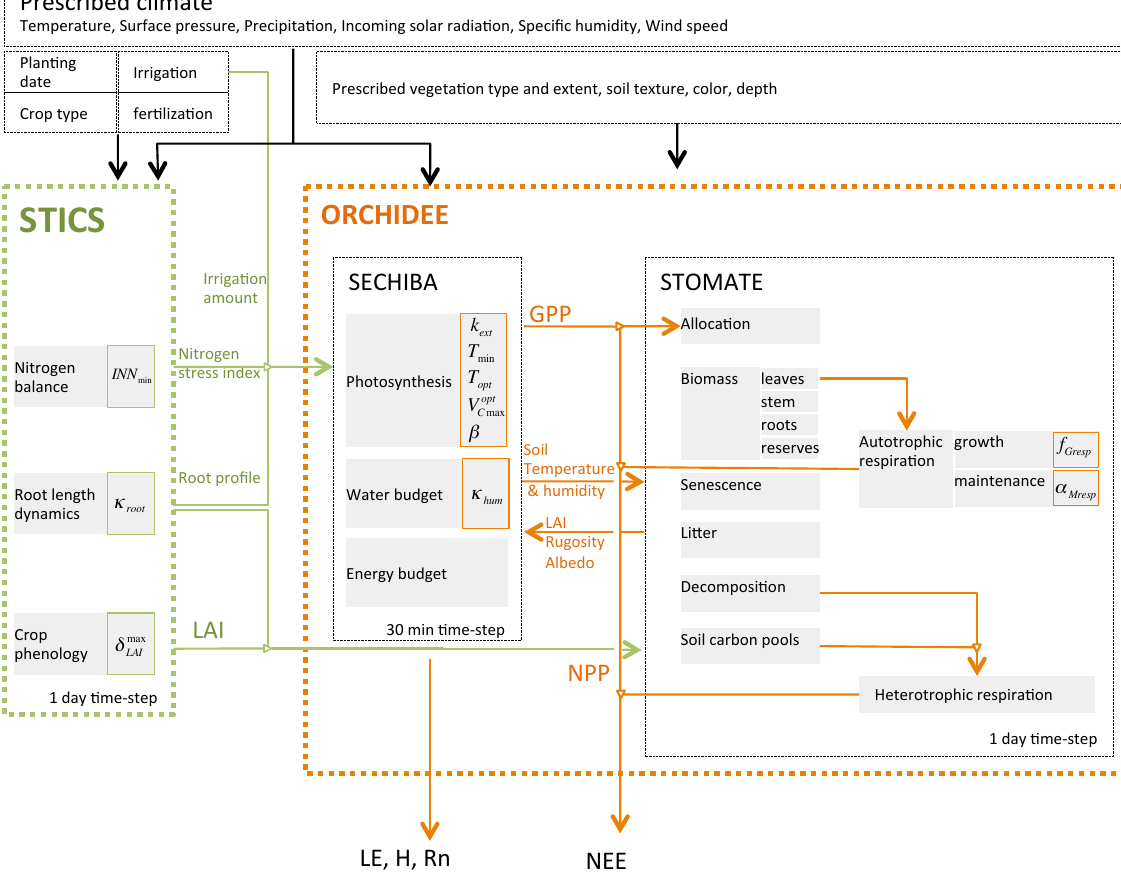
Figure 3. Structure of the ORCHIDEE–STICS chain model. STICS calculates the crop phenology, water and nitrogen requirements and passes LAI, root profile, irrigation and nitrogen nutrition index to ORCHIDEE. ORCHIDEE consists in the coupling of two module. SECHIBA simulates the photosynthesis process, water and energy budgets; STOMATE is a carbon module and calculates carbon fluxes and to the atmosphere (respiration) and carbon accumulation in the carbon pools (biomass compartments, litter, soil).